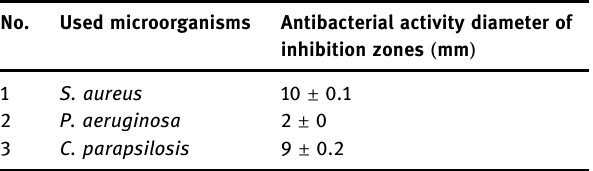
Table 4: Antibacterial activities of AgNPs [ 20